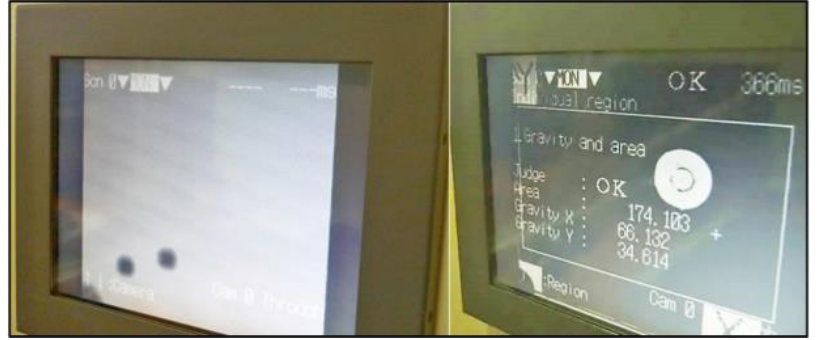
Figure 5. Incorrect procedures for determination of the sensed objects at the measured scene.